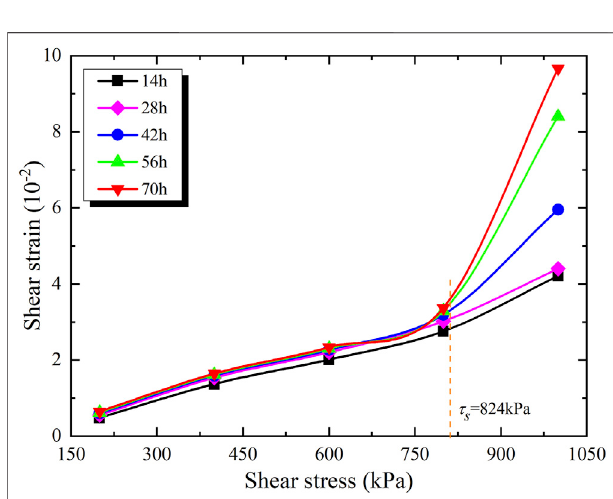
FIGURE 9 | Relationship between steady strain rate and shear stress. FIGURE 10 |